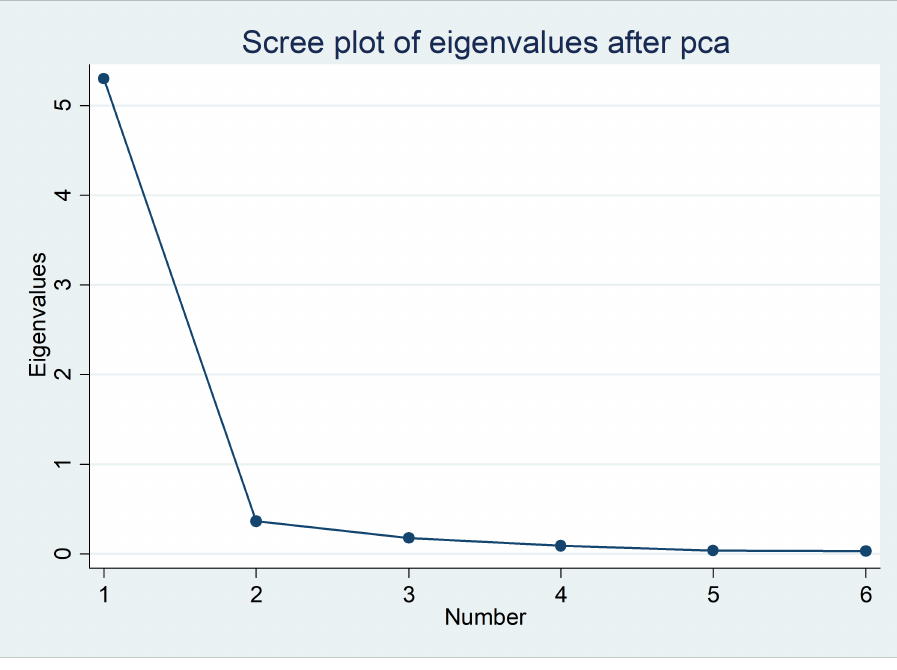
Figure A. 3: Cattell Scree test for component